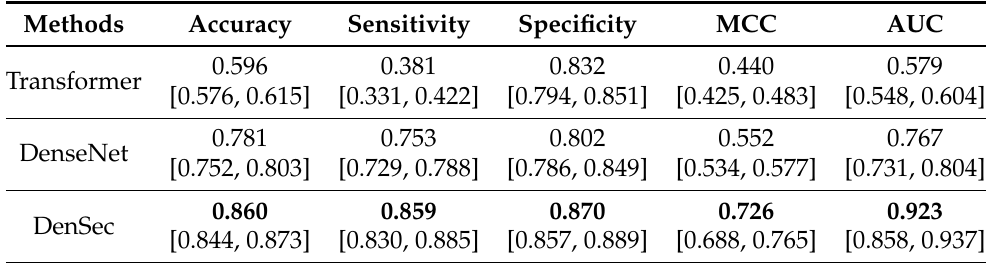
Table 4. Comparison of performances for different model